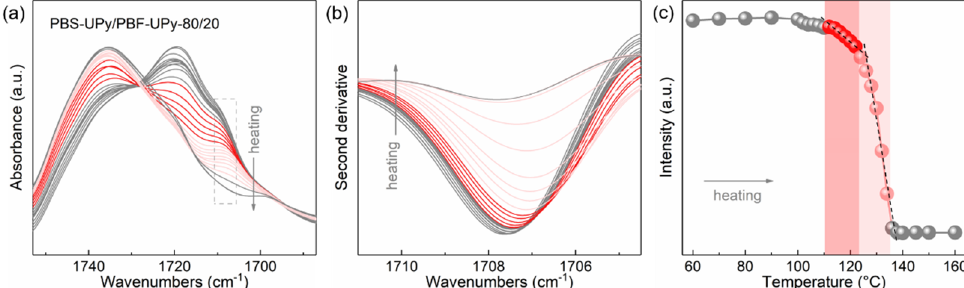
Figure 6. In situ FTIR spectra of blend PBS ‐ UPy/PBF ‐ UPy ‐ 80/20 ( a ) and their second derivatives ( b ) collected upon heating process from 60 to 160 °C after being melt ‐ cooled at a rate of 40 °C/min, and the trend of characteristic peak intensity as a function of temperature ( c ).